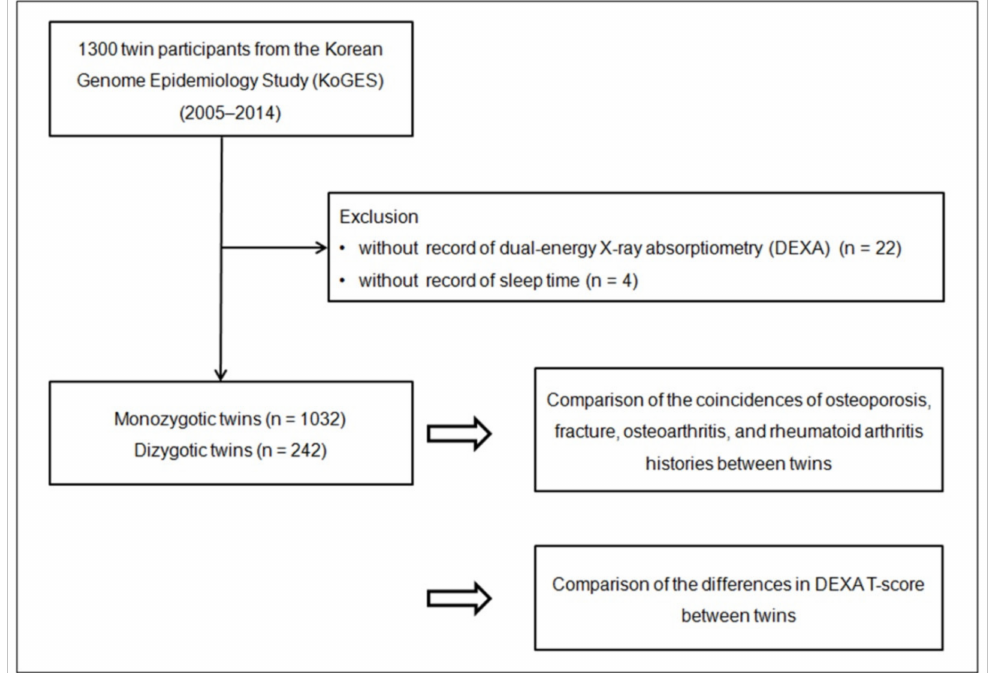
Figure 1. The study design of the present study; 1032 monozygotic twins and 242 dizygotic twins were compared for concordance of several aging-related bone and joint diseases, including osteoporosis, fracture, osteoarthritis, and rheumatoid arthritis between twins. DEXA T-scores for bone mineral density were also